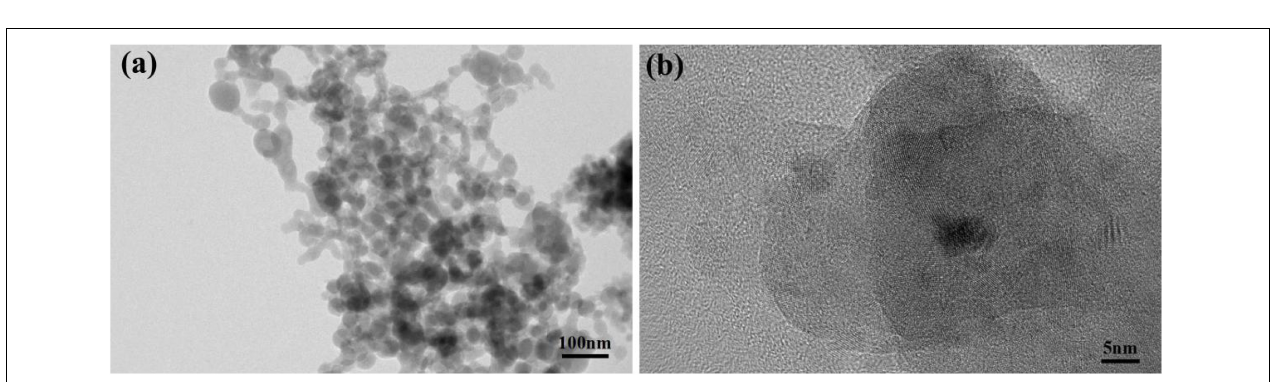
FIGURE 2 | Microstructures of sodium aluminum silicate nano-clusters. (a) TEM observations of the inorganic component. (b) Zoomed-in view of A.